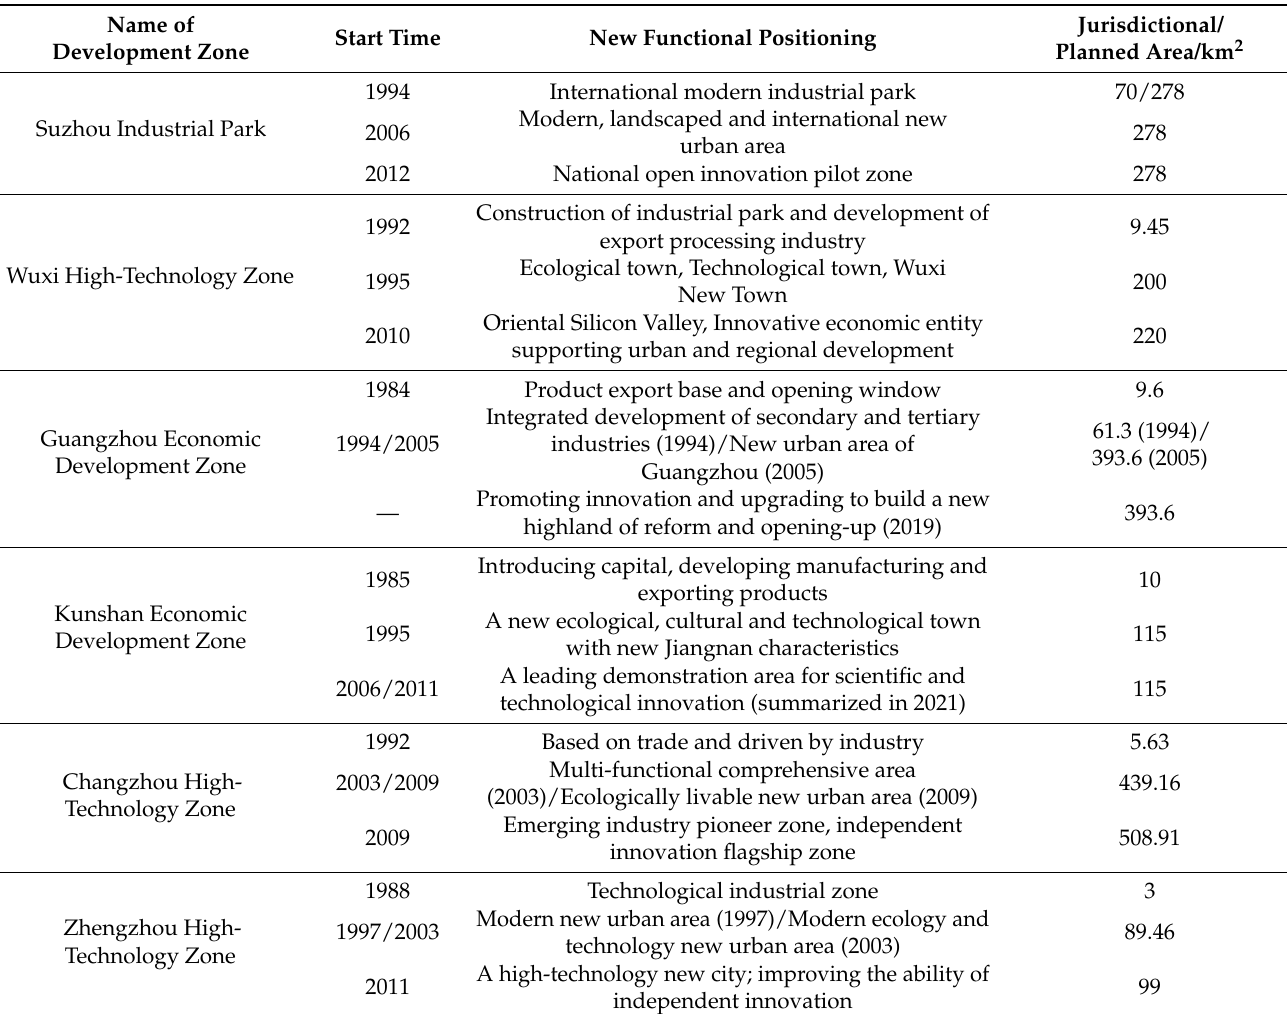
Table 1. Restructuring of growth priorities in some development zones